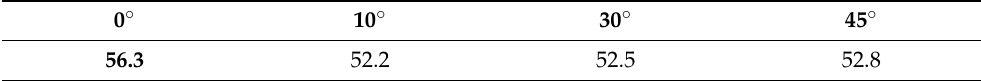
Table 8. Accuracy (%) of cutting plane angle rotation experiment on M10 →